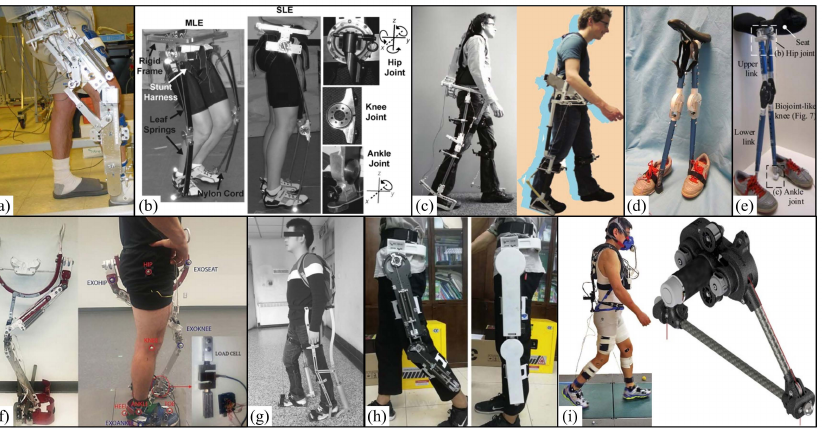
Figure 5. Multi-joint passive lower limb assisted exoskeletons. ( a ) University of Delaware, GBE